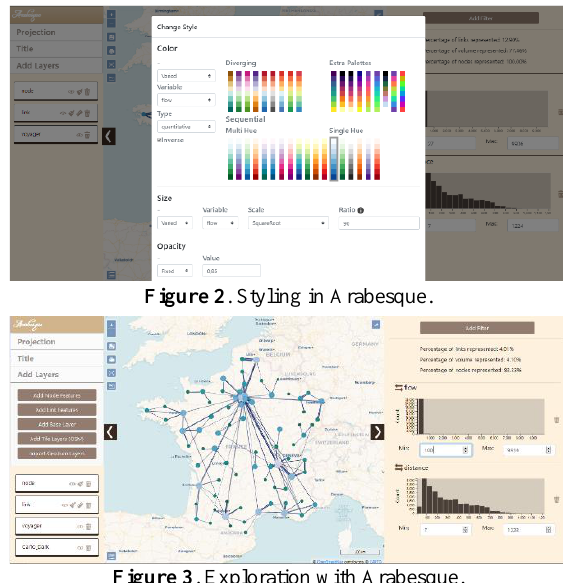
Figure 3 . Exploration with Arabesque.